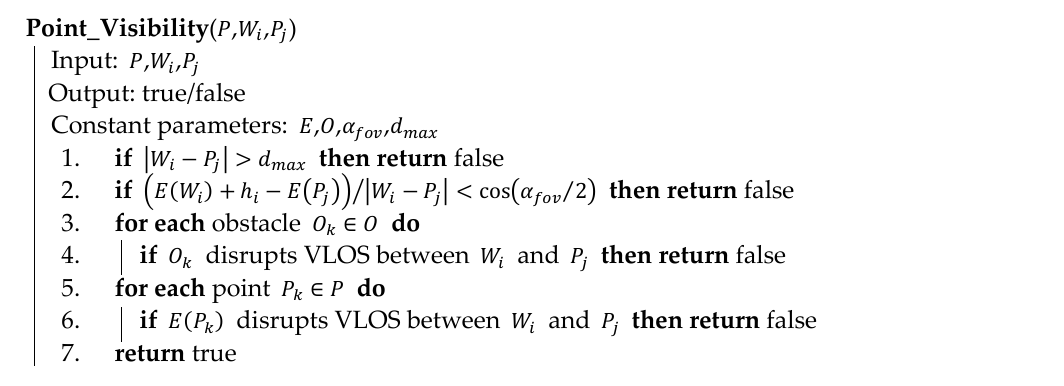
Algorithm 2 Visibility evaluation between a point and a waypoint in pseudocode